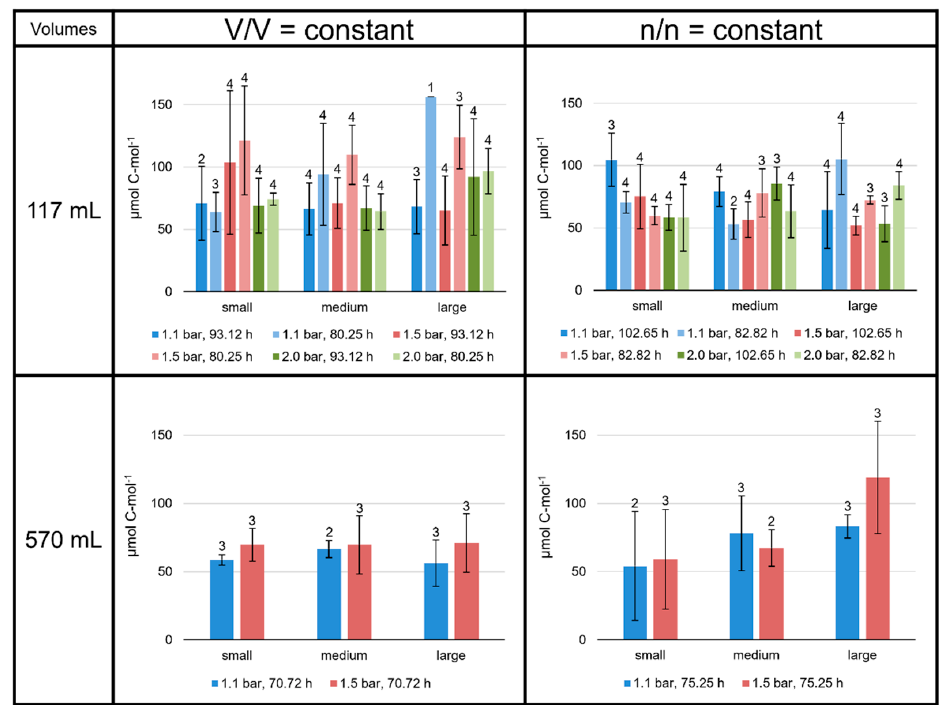
Figure 4. Product-to-product yields of total lipids in M. marburgensis cultures. Pressure is given in bar relative to atmospheric pressure. Yields are given in µ mol C-mol − 1 . Errors are standard deviations. Numbers above bars indicate number of samples. Samples quantified with 5- α -cholestane standard are indicated in Tables S4–S9.